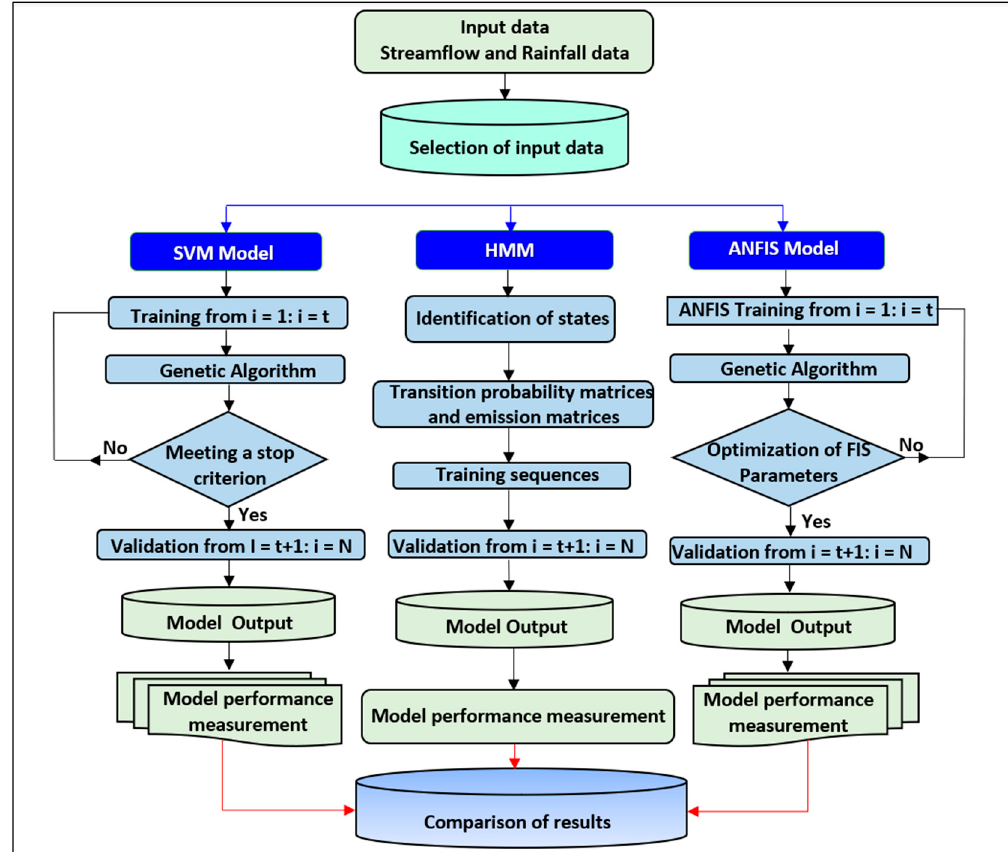
Figure 7. Schematic diagram of the methodology presented in this study.